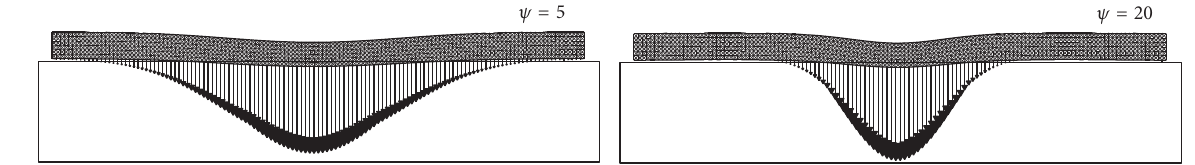
Figure 3: Deformed meshes and contact forces on Γ 3 for 𝜓 = 5 and 𝜓 = 20 , without friction.